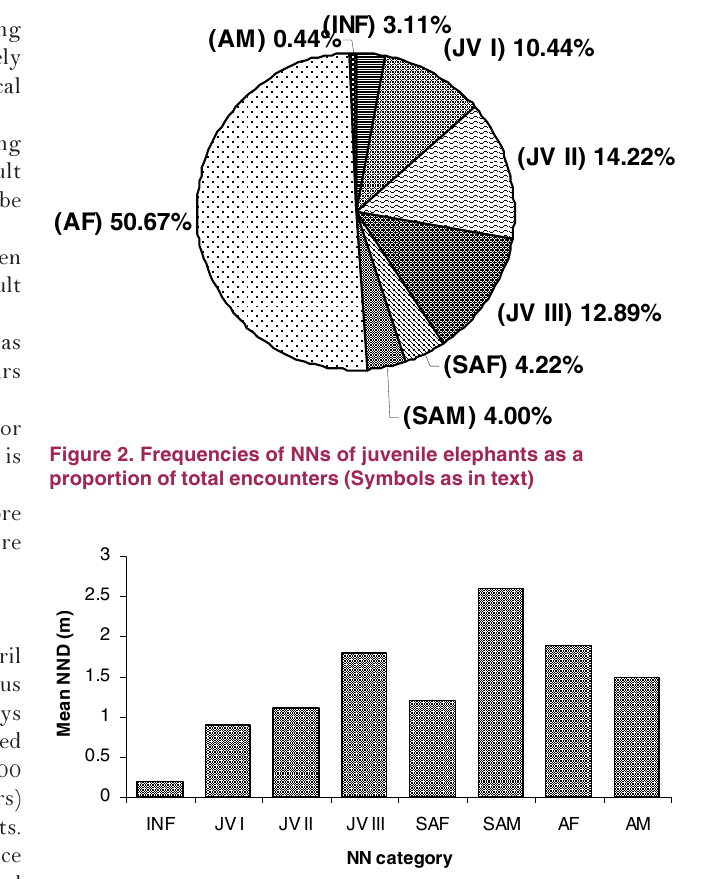
Figure 3. Mean NND between focal juvenile elephants and different NNs. (Symbols as in